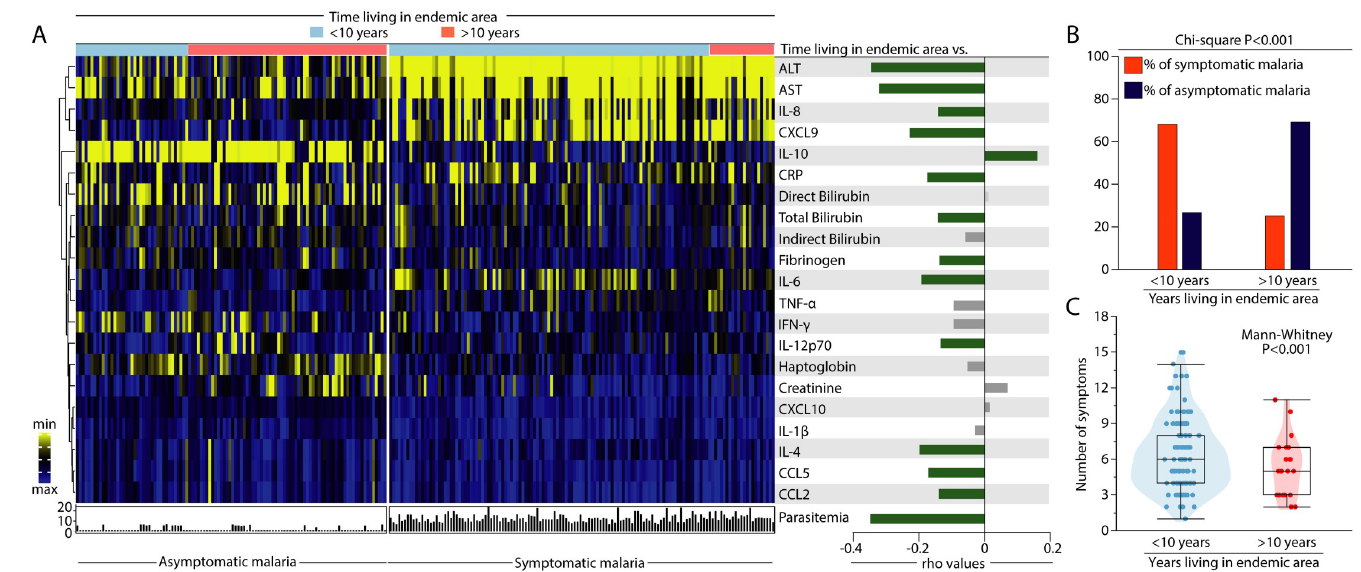
Fig 3. Patients with Plasmodium vivax malaria living longer in the endemic area display an attenuated systemic inflammatory disturbance. (A) Left panel: to build the heatmap, data were log-transformed and z-score normalized. A one-way hierarchical cluster analysis (Ward’s method) was employed to show the profiles of the molecular degree of perturbation of participants according to time living in an endemic area (patients were ordered according to time living in an endemic area). Patients were divided in two groups based on time living in the area (those who have lived for less than 10 years or for more than 10 years) and whether they presented with symptomatic or asymptomatic malaria. Right panel: Spearman rank test was used to assess correlations between the individual MDP score values of each parameter or parasitemia and time living in an endemic area (in years). Bars indicate the Spearman coefficient (rho) values. Green bars to the right indicate positive whereas to the left denote negative correlations with adjusted P-values < 0.05. Grey bars indicate non-significant correlations. (B) The Pearson’s chi-square test was used to compare the frequency (percentage) of symptomatic and asymptomatic malaria participants according to the years living in an endemic area. (C) A violin plot was used to show the number of symptoms in the participants stratified according to years living in an endemic area. Data were compared using the Mann-Whitney U test. Abbreviations (alphabetic order): ALT: alanine aminotransferase; AST: aspartate aminotransferase; CCL: C-C motif chemokine ligand; CXCL: C-X-C motif chemokine ligand; CRP: C- reactive protein; IFN: interferon; IL: interleukin; TNF: tumor necrosis factor.